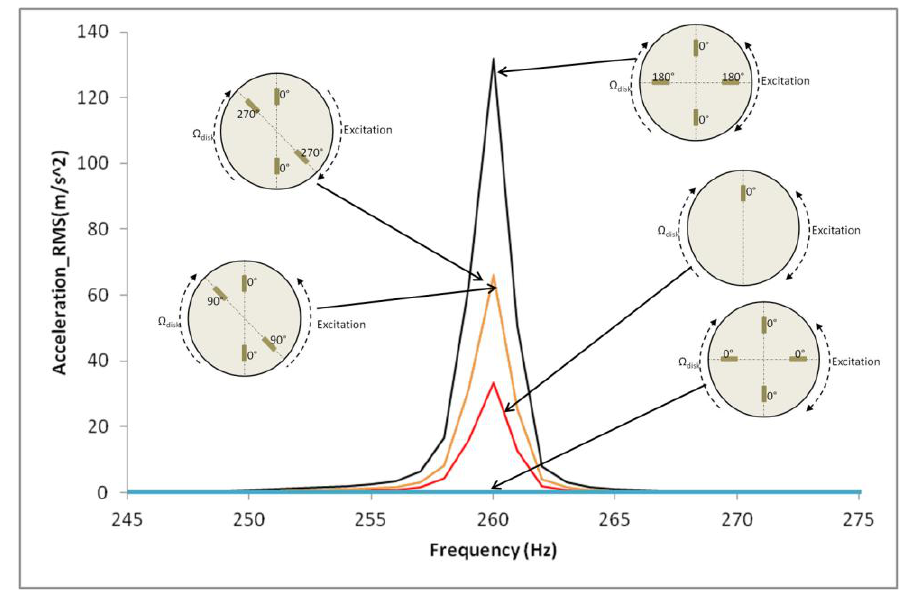
Figure 11. Resonances around n = ±2 (experimental) for the disk rotating in air ( = 8 Hz). Different excitation patterns. disk